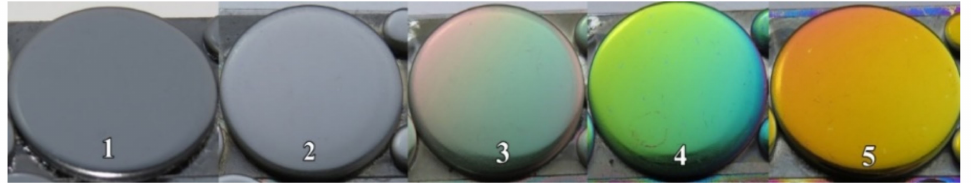
Figure 10. The perceived colour of the TaTiON coatings: 1—Ta1–Ti0–ON; 2—Ta0.75–Ti0.25–ON; 3—Ta0.5–Ti0.5–ON; 4—Ta0.25–Ti0.75–ON;